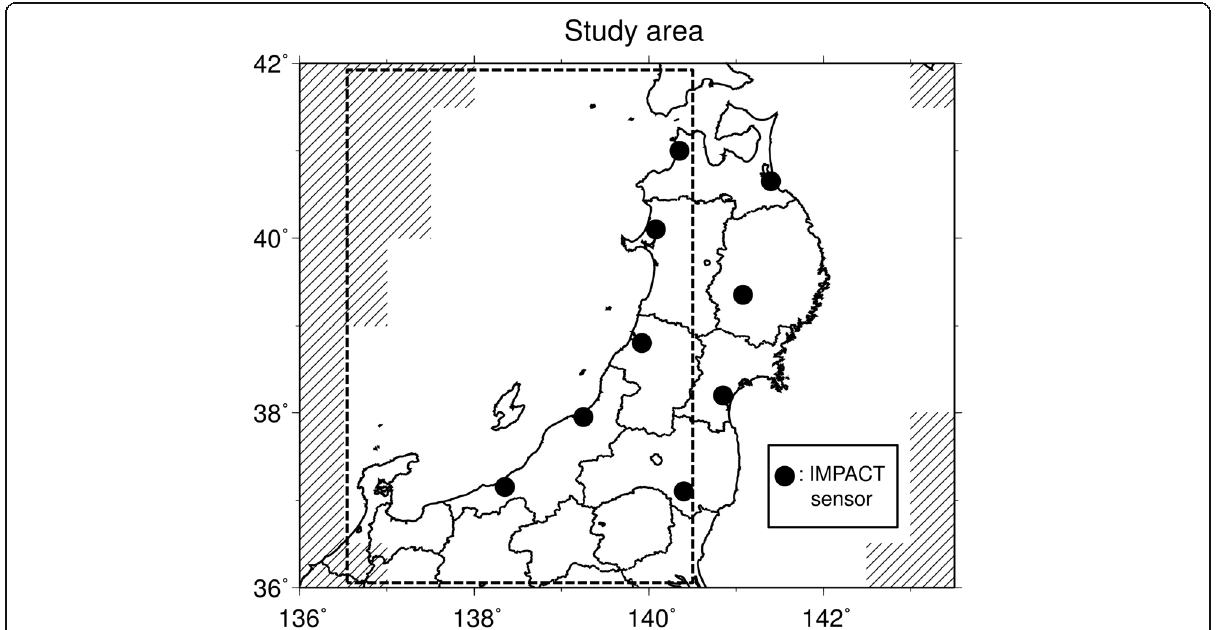
Fig. 2 Locations of IMPACT sensors and the study area. Meshed areas indicate zones of undetectable lightning discharges with absolute peak currents below 10